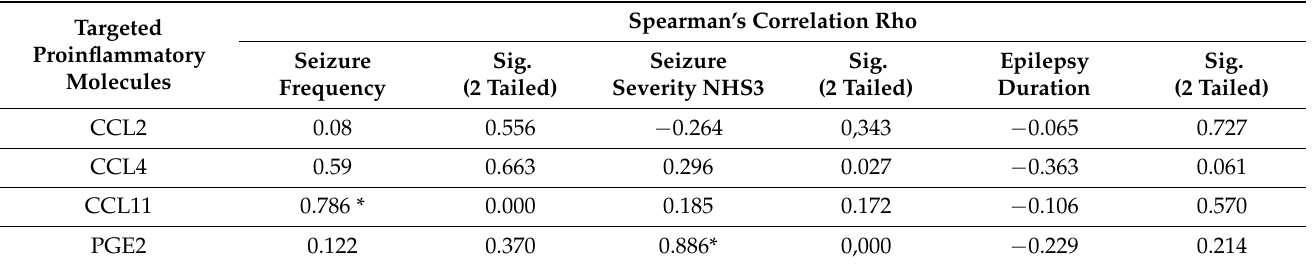
Figure 3. Correlation of targeted proinflammatory cytokines in pg/mL and seizure severity scores presented as scatterplots with Loess fit lines: ( a ) PGE2 and seizure severity scores; ( b ) CCL11 and seizure severity scores; ( c ) CCL4 and seizure severity scores; ( d ) CCL2 and seizure severity scores. Table 4. Correlations between targeted proinflammatory molecules with the seizure frequency per month and with the severity of seizures in drug-resistant epilepsy patients.